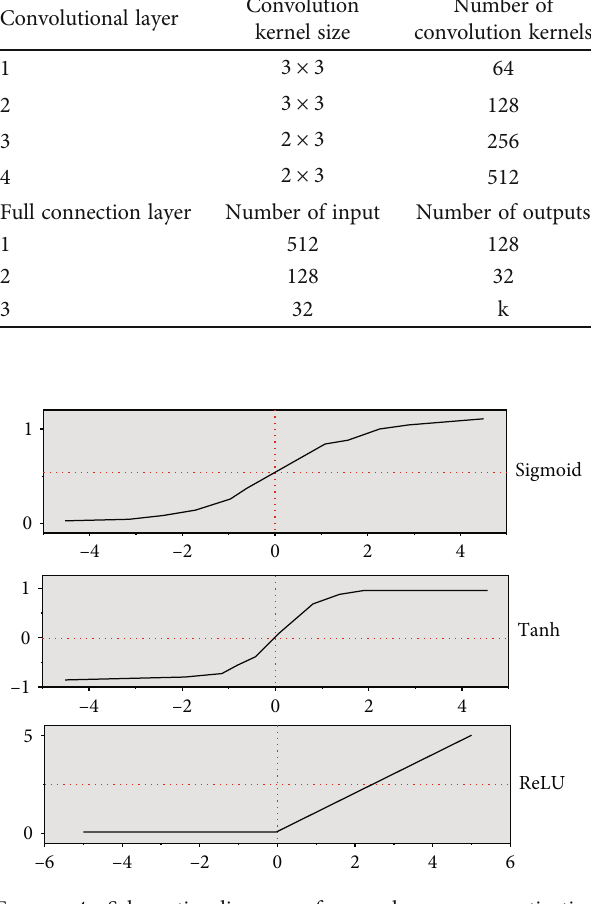
Figure 4: Schematic diagram of several common activation functions.